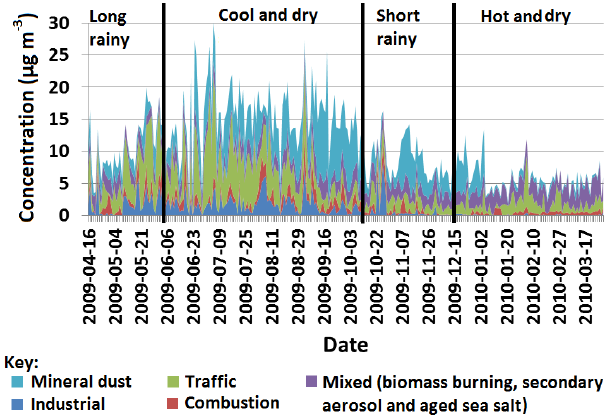
Figure 14. Seasonal variation of the five factors obtained from the PMF analysis of the PM 2 . 5 composition at the UNEP site. The mixed factor constitutes contribution from biomass burning sec- ondary aerosol and aged sea salt. The effect of the erratic weather pattern is evident from the dampened contribution of mineral dust factor in 2010. Seasons have been demarcated for